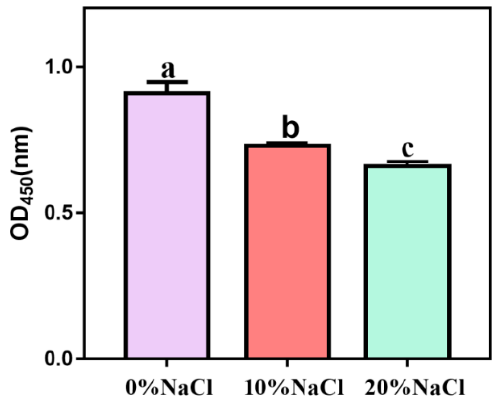
Figure 3 . Hemolytic activity of S. aureus during change in salinity.